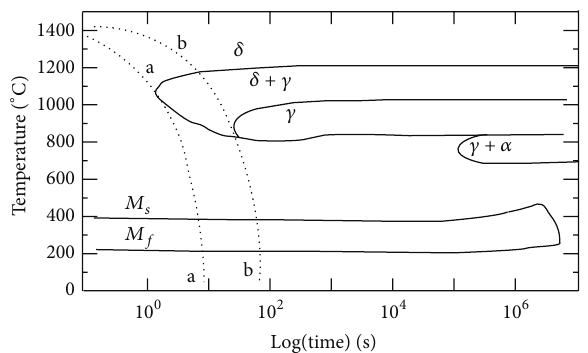
Figure 2: Continuous cooling transformation of 𝛿 -ferrite to 𝛾 in the HTHAZ during weld thermal cycle